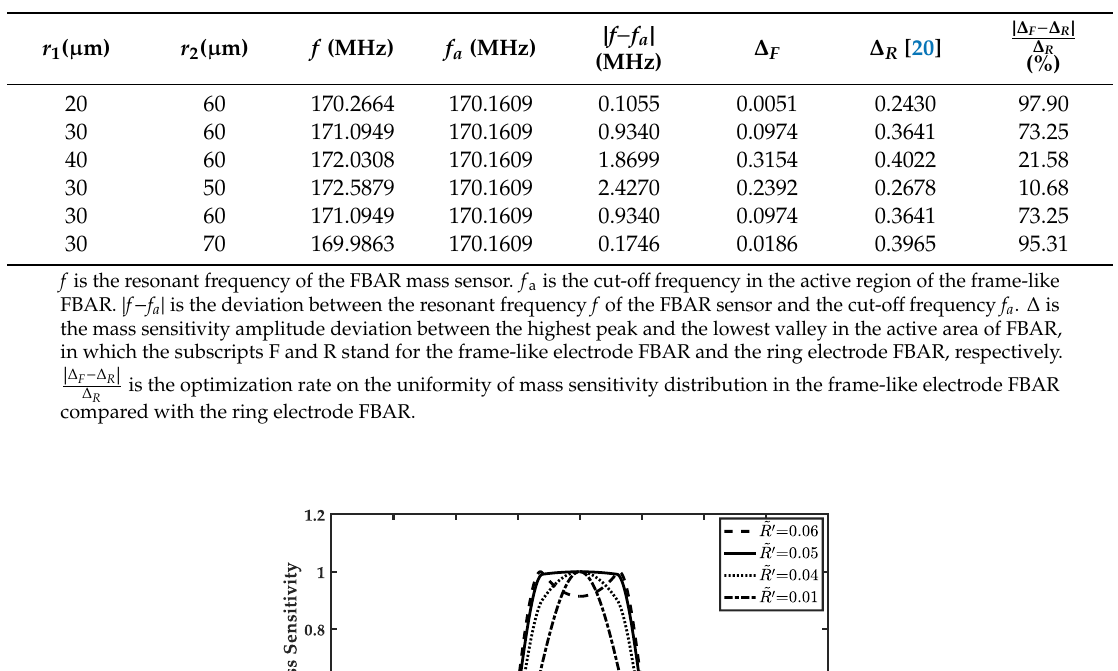
Table 1. The comparison on the uniformity of mass sensitivity of the frame-like electrode FBAR sensor for different electrode sizes, with (cid:101) R (cid:48) = 0.04 .